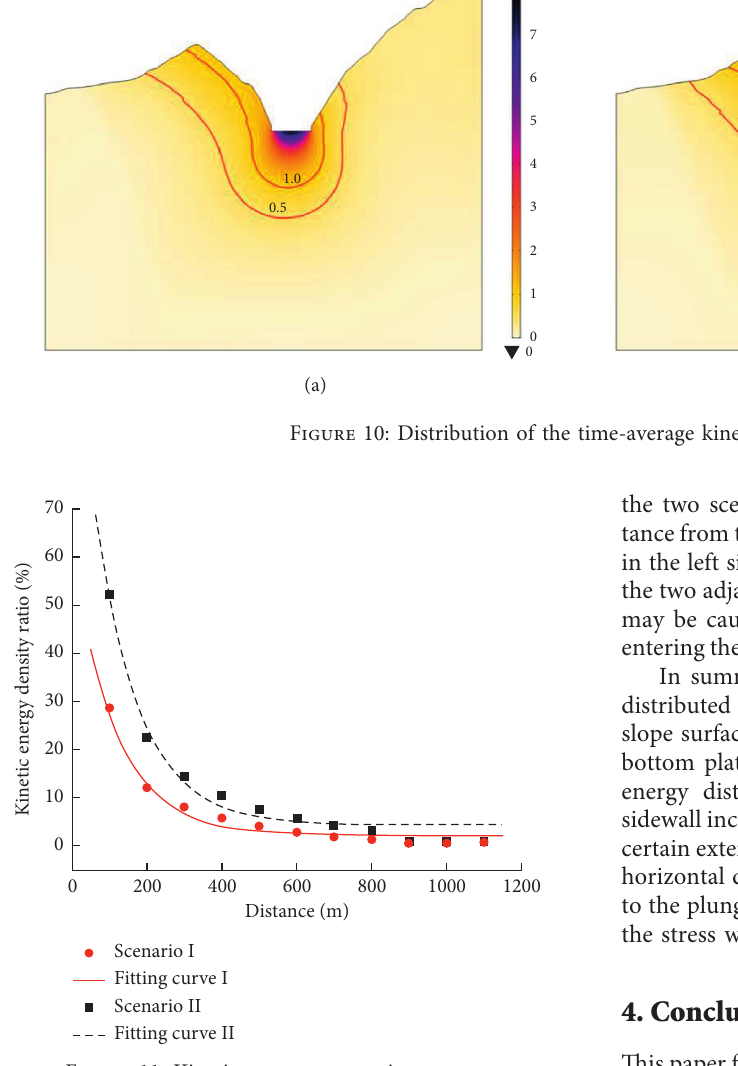
Figure 11: Kinetic energy attenuation curves.